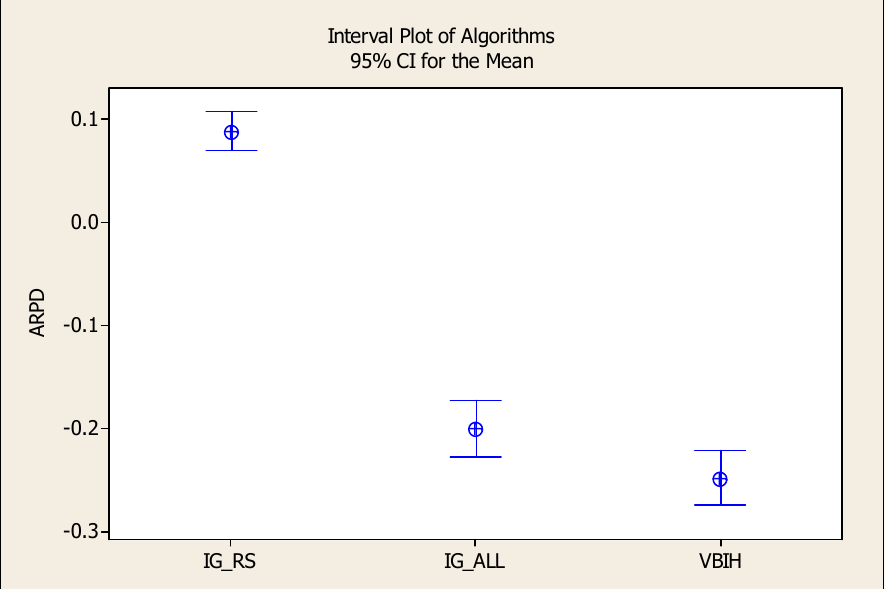
Figure 9. Interval plot at the 95% confidence level for large VRF instances.